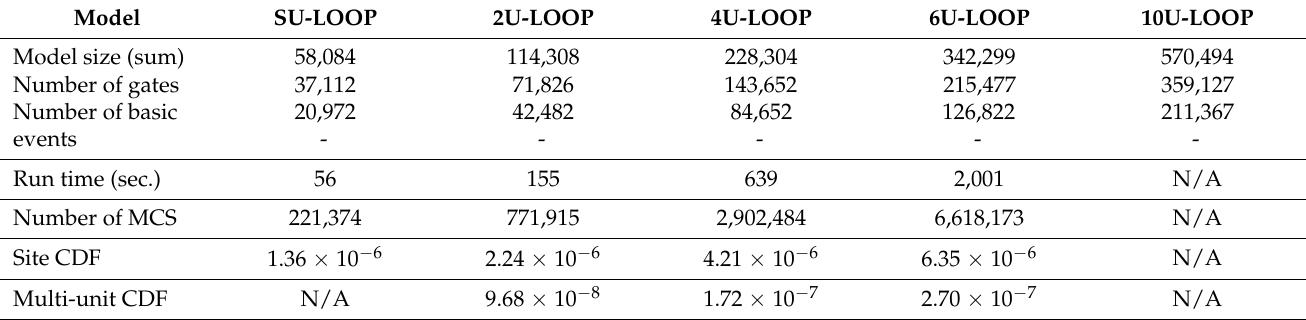
Table 4. Comparison of quantification results by the number of units (without